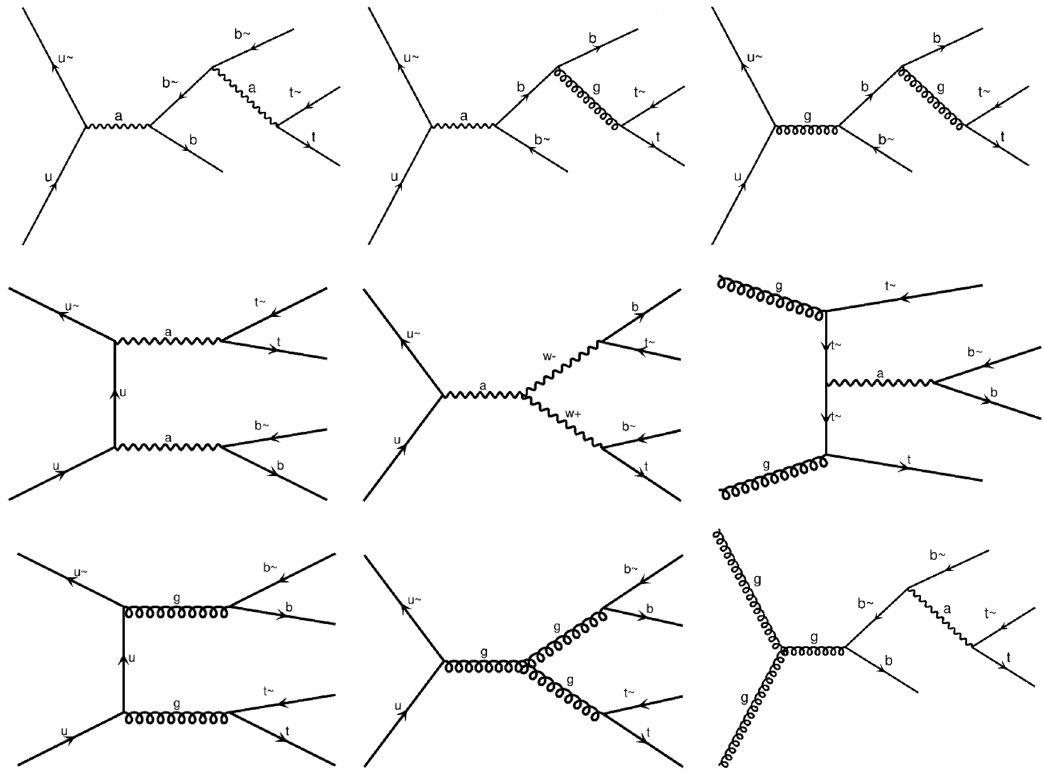
Figure 6 . A selection of background Feynman